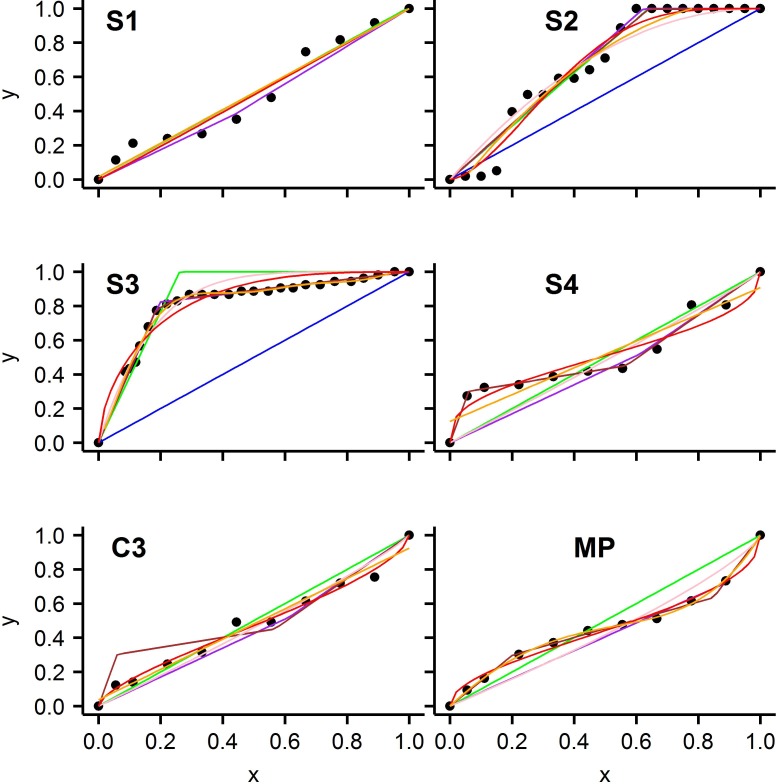
Results of fitting all 7 models to each of six selected animals.Each panes is a separate animal and the name of the best fitting model for the animal is given at the top of the panel. Black dots are the observed data points. Solid lines are: blue = S1, green = S2, purple = S3, brown = S4, pink = C2, red = C3, orange = MP.